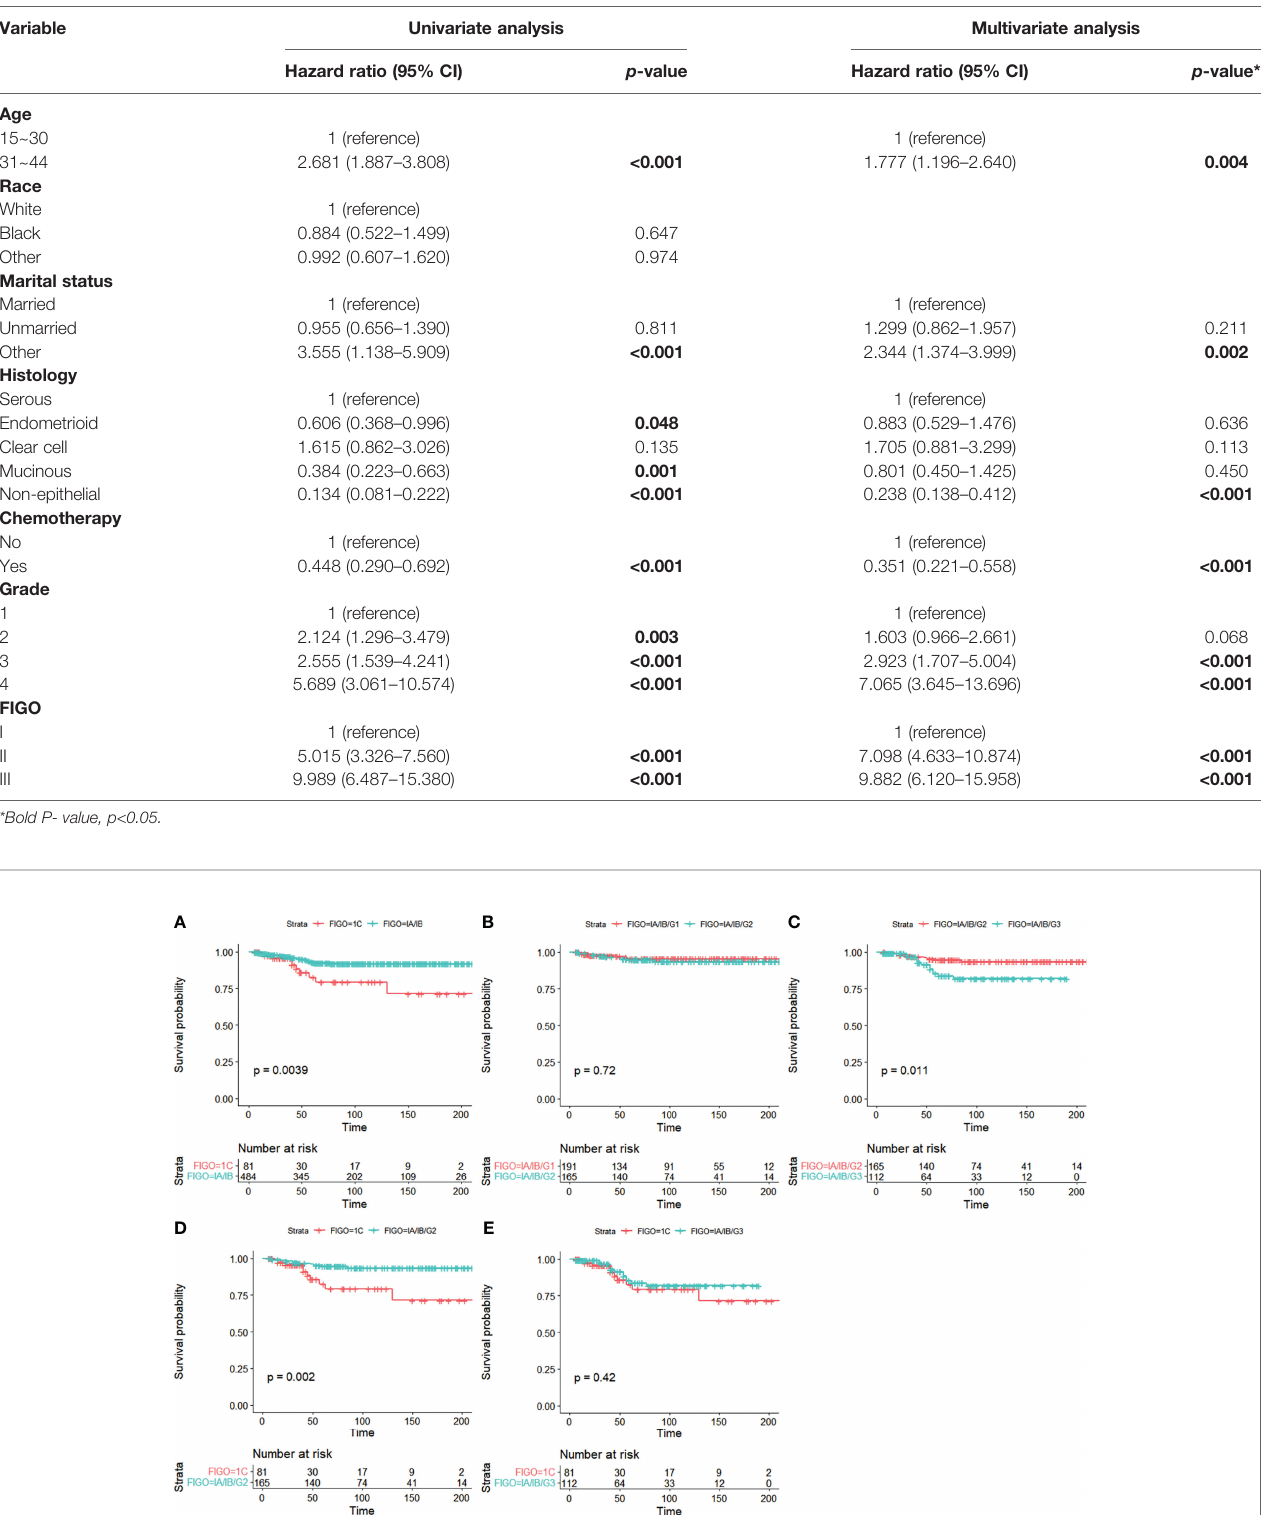
TABLE 3 | Univariate and multivariate Cox regression of cancer-speci fi c survival among OC women with